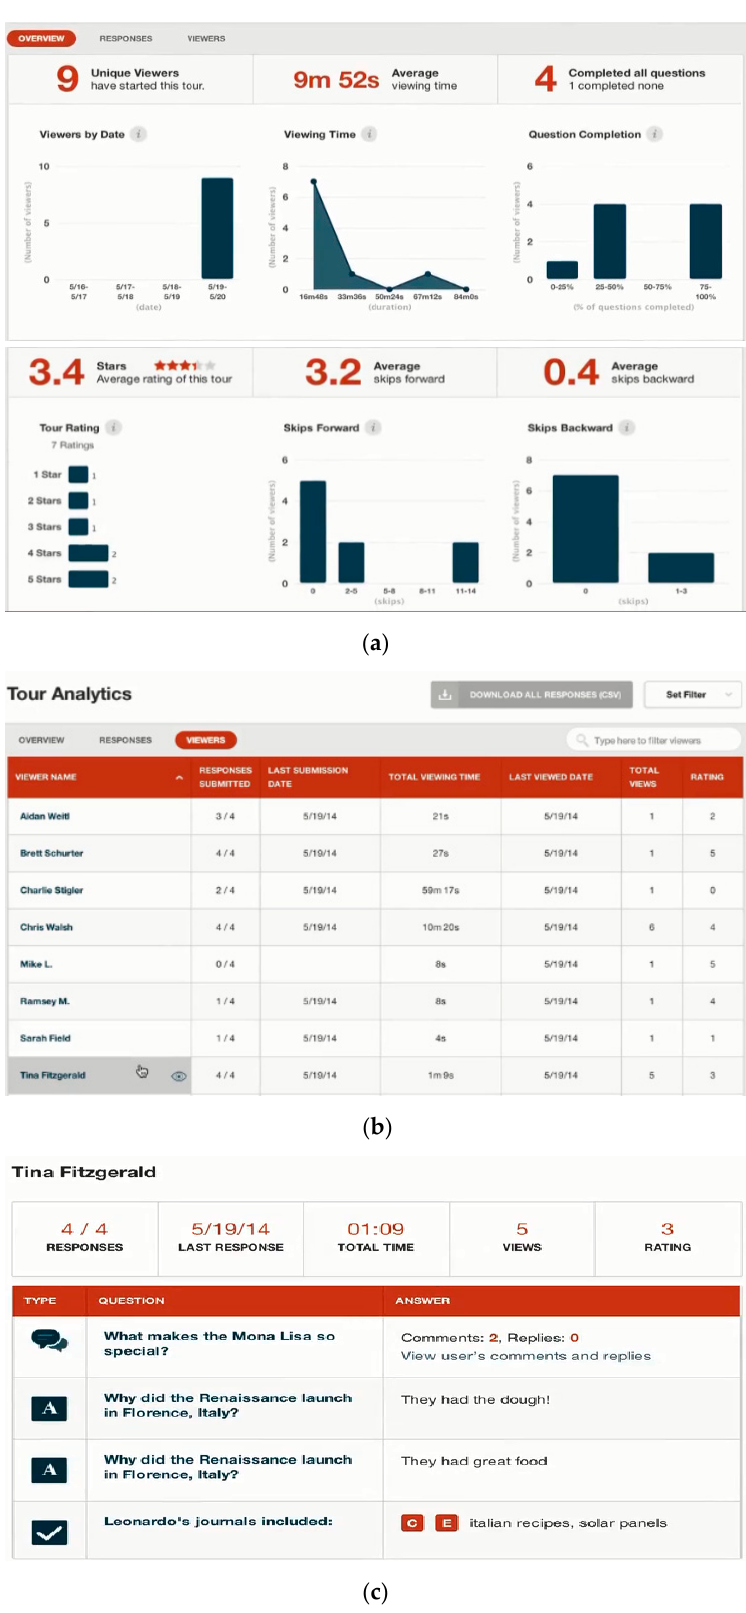
Figure 1. ( a ) Overview graph of Zaption; ( b ) Viewer’s tour analysis of Zaption; ( c ) The video quizzes and answers for each student in Zaption.